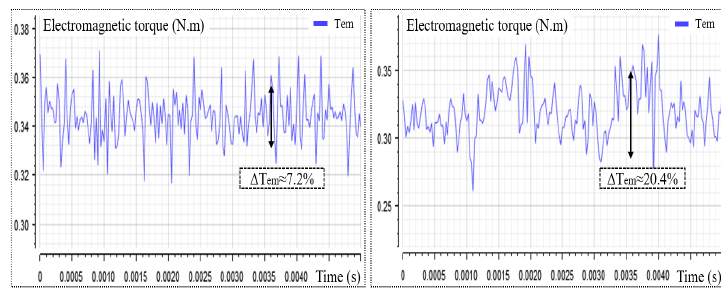
Figure 13. DQ currents before and after the fault on phase A.